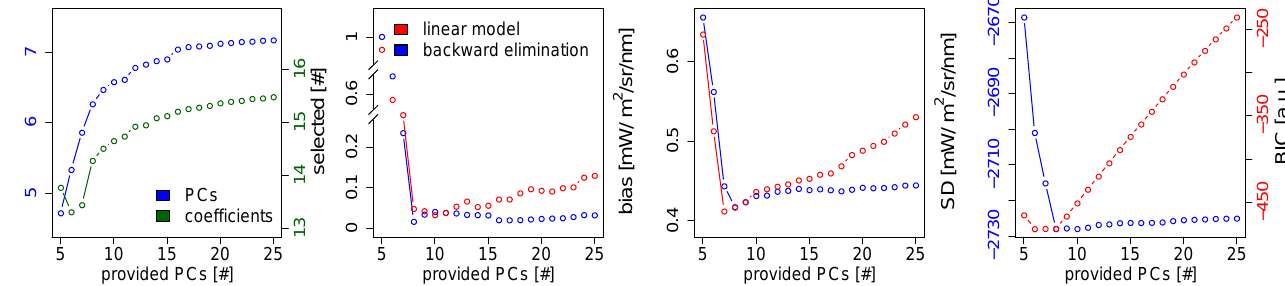
Figure 8. The plot on the left shows the average number of selected PCs (blue) and coefficients (green) as a function of PCs provided to the backward elimination algorithm. In the following, the retrieval results for the linear model fit using all potentials coefficients (red) are compared to the backward elimination fit (blue). Depicted are the bias (mean difference of retrieved minus input SIF), the average standard deviation of retrieved SIF for the 60 TOC SIF spectra (SD) and the mean Bayesian information criterion (BIC).